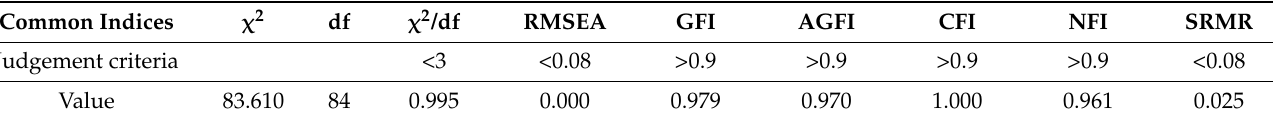
Figure 7. Structural equation model. Figure 6. Structural equation model. Table 11. Adaptability of SEM. Table 11. Adaptability of